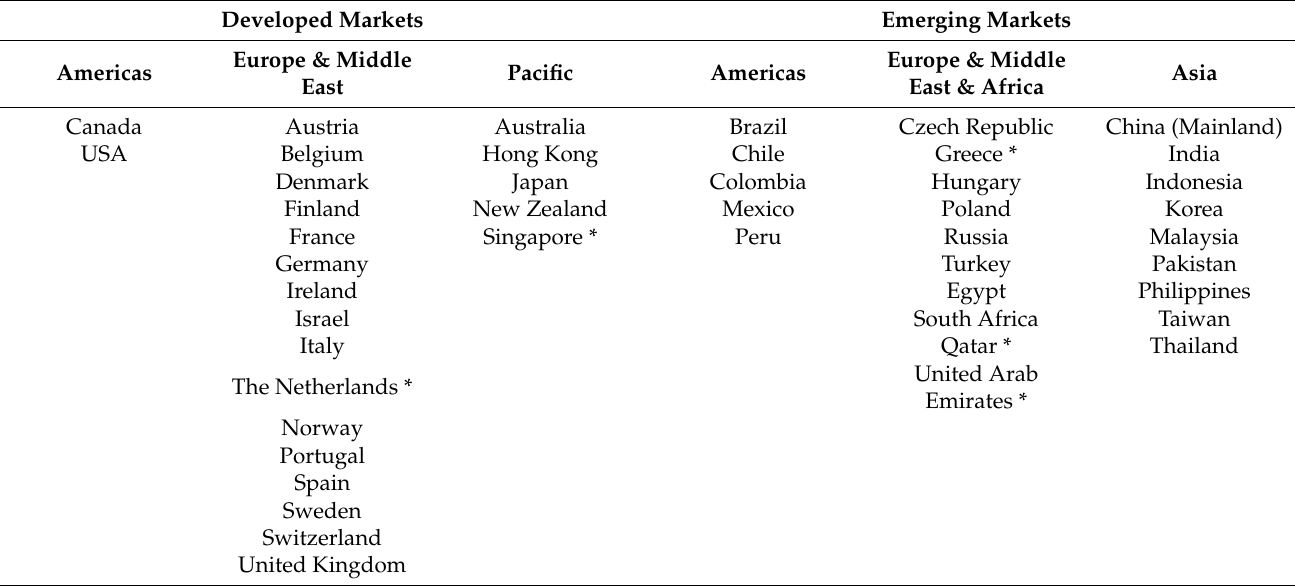
Table 1. The categories of major stock and sovereign CDS markets in the MSCI ACWI (All Country World Index). There are 23 developed economic entities and 24 emerging countries or areas. The geographical regions contain Americas, EMEA (Europe, Middle East and Africa), Pacific and Asia. Markets with * have missing sovereign CDS data in our data